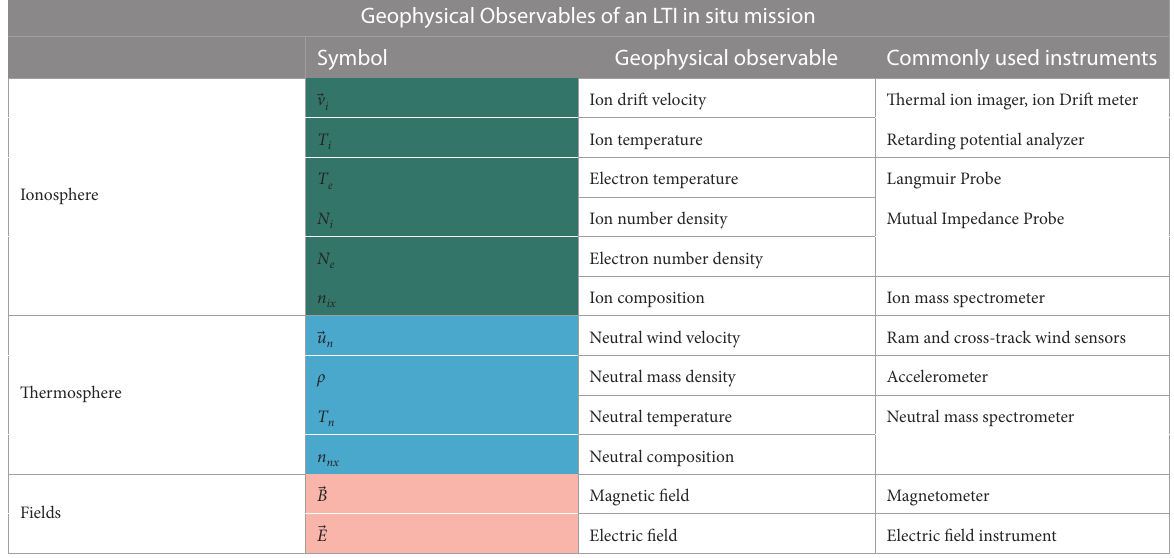
TABLE1 Listofprimaryproductsorgeophysicalobservablesneededtoaddressthesciencequestionslistedhereinandcommonlyusedinstruments